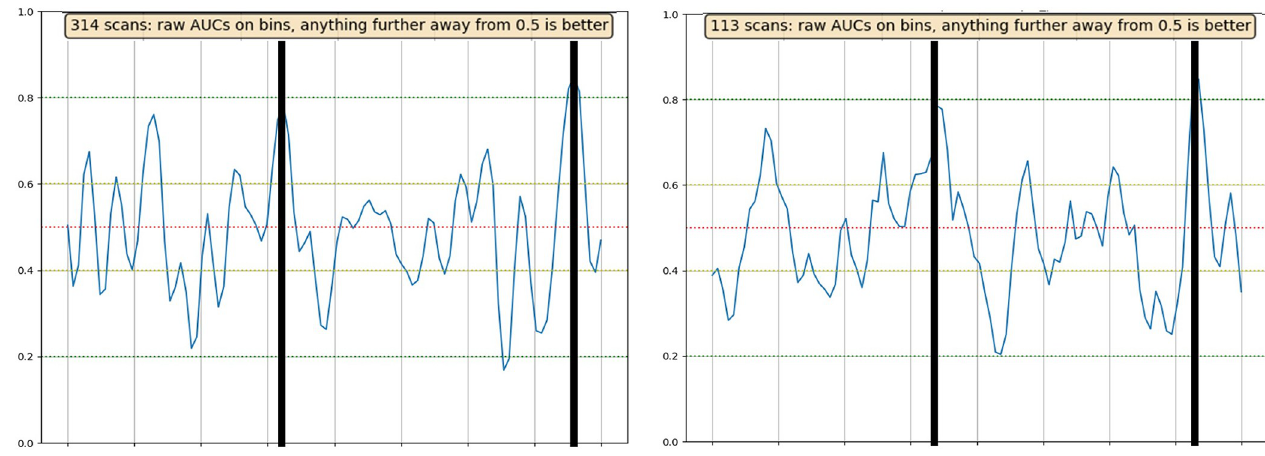
Fig 2. Separation capabilities between clear and non-clear samples based on biomaterial spectral signatures, where the X-axis was the THz frequency range, and the Y-axis was the measurable index for differentiation ability (0.0 to 1.0).